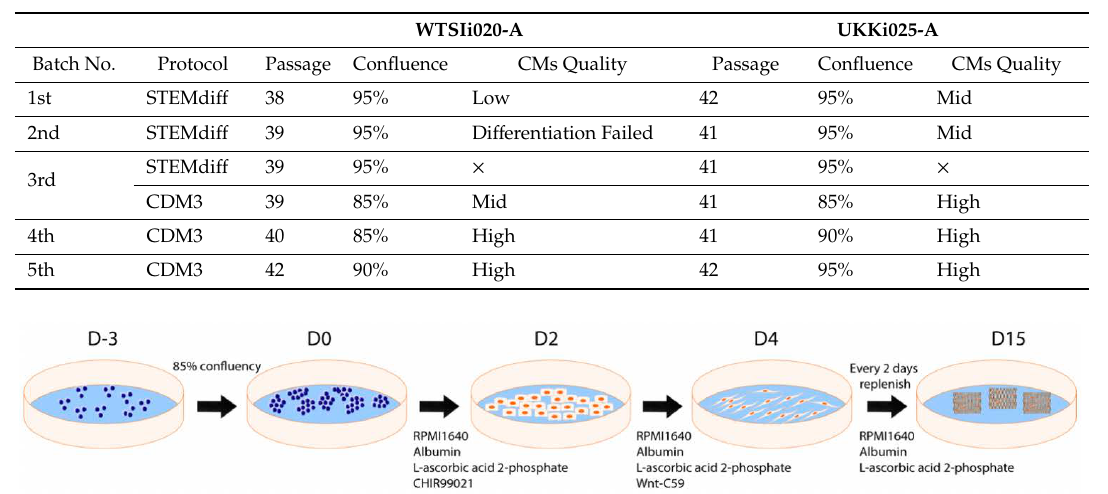
Figure 1. Illustration of hiPSC differentiation with Chemically-Defined Medium 3 (CDM3) protocol adapted from Burridge et al. [21].